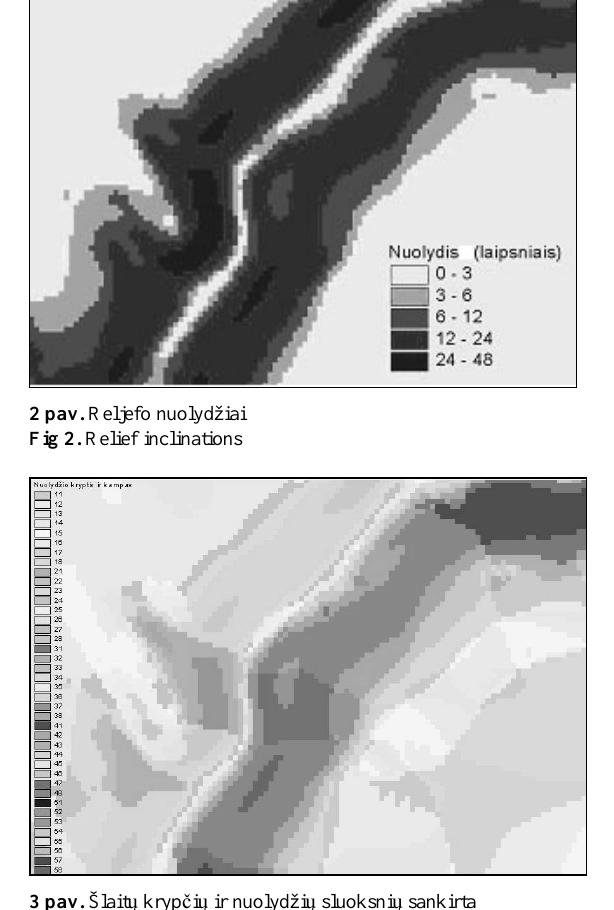
Fig 5. Intersection of layers of relief relative variability and inclinations